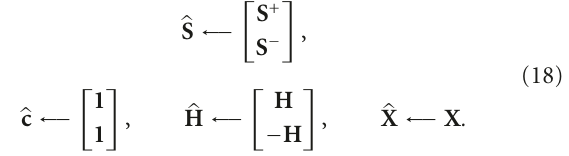
measure for the considered vector space. Therefore, it can easily be applied to the complex-valued data that occurs in time-frequency domain convolutive